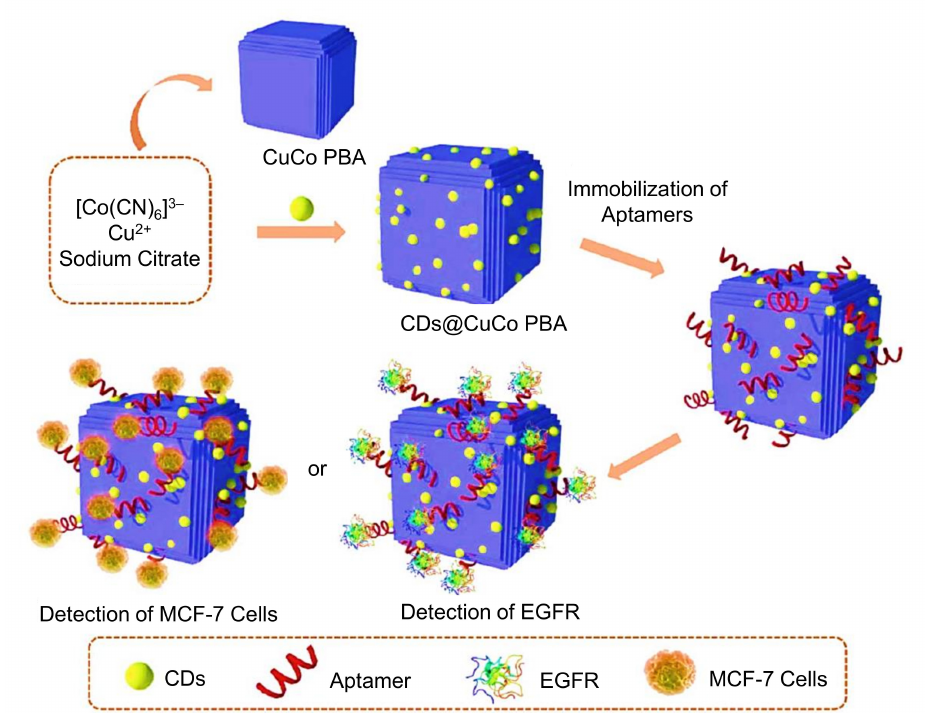
Figure 15. Graphical illustration of the fabrication of an aptamer-based biosensor, involving the use of CDs@CuCo PBA for the detection of EGFR, and EGFR-overexpressed MCF-7 breast cancer cells. Reproduced from [230], with permission from the Royal Society of Chemistry,